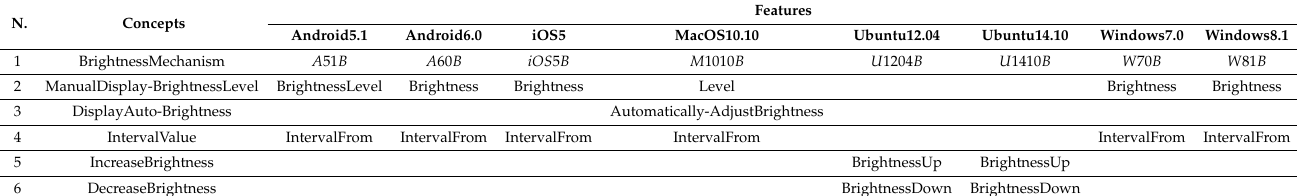
Table 1. Mapping between features and ontology concepts for Brightness. In row BrightnessMechanism , names have been shorten, e.g., A 51 B stands for Android 5.1_ Brightness .